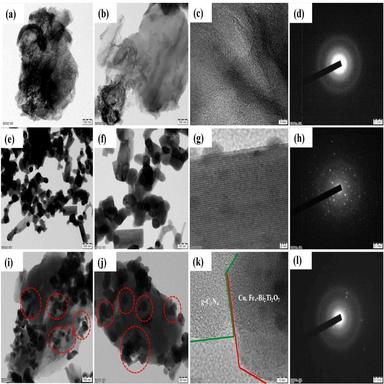
(a) and (b) are TEM, (c) HR-TEM, (d) SAED pattern of the EG- g-C3N4; (e) and (f) are TEM, (g) HR-TEM, (h) SAED pattern images of the Cu, Fe co-doped Bi2Ti2O7; (i) and (j) are TEM, (k) HR-TEM, (l) SAED pattern images of the Cu, Fe-BTO/EGCN.